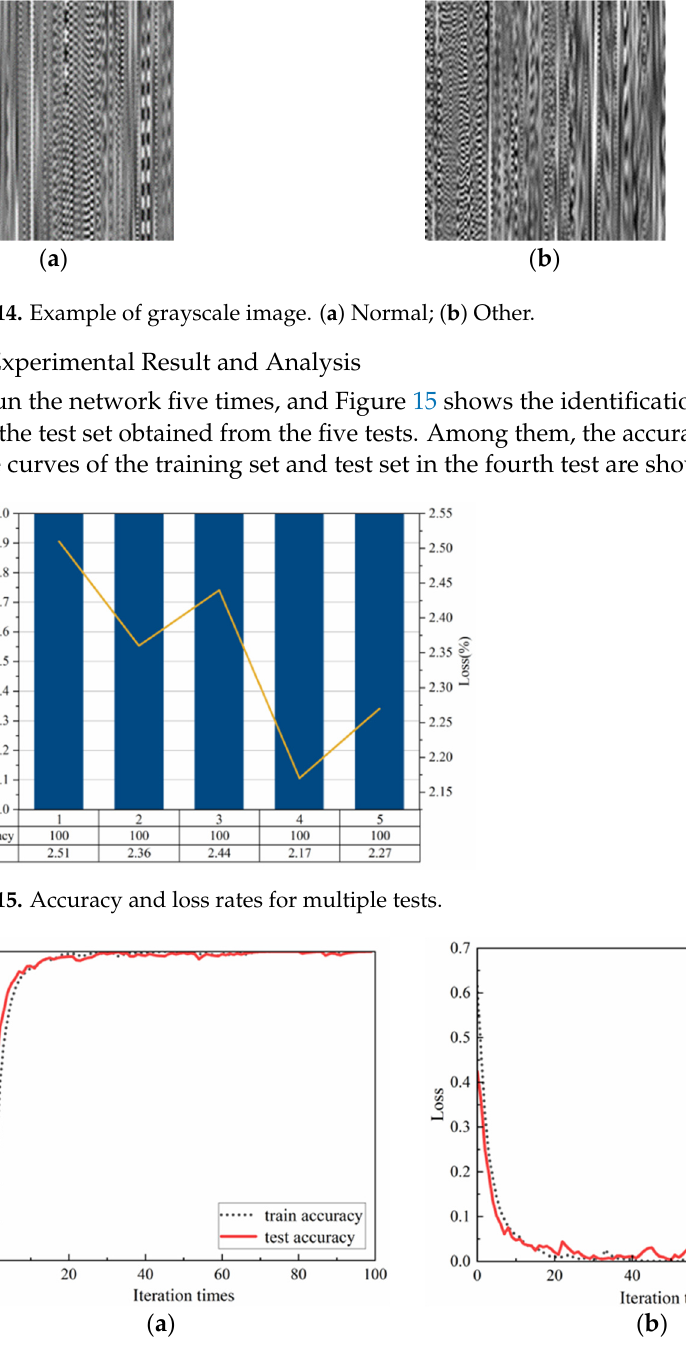
Figure 16. Accuracy changes and loss changes of training set and test set. ( a ) Accuracy changes. ( b ) Loss changes.